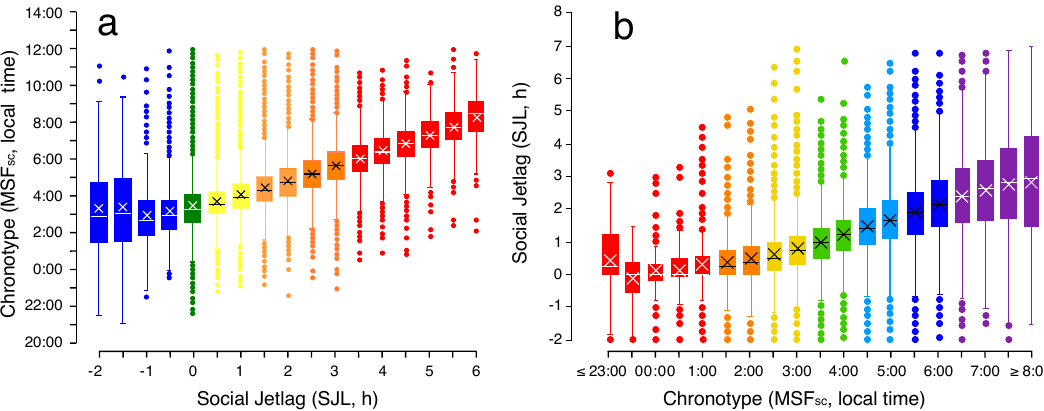
Figure 5. Interrelationship between chronotype (MSF sc ) and social jetlag (SJL). ( a ) On average, increasing SJL is associated with increasing lateness in chronotype; color-coding is chosen according to the distribution shown in Figure 4. ( b ) Inversely, the later the chronotype, the stronger the SJL. Color-coding is chosen according to the distribution shown in Figure